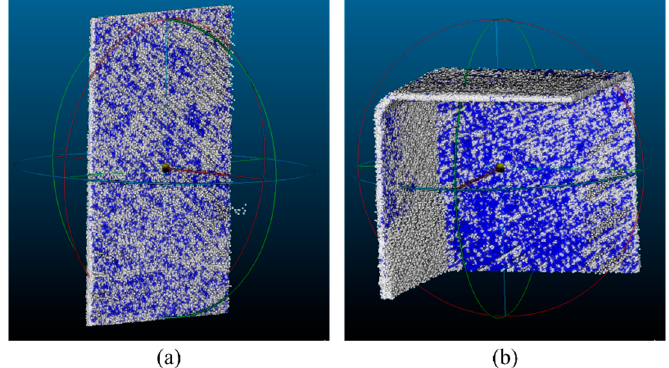
Figure 3. ( a ) RANSAC on one object; ( b ) RANSAC on three objects.